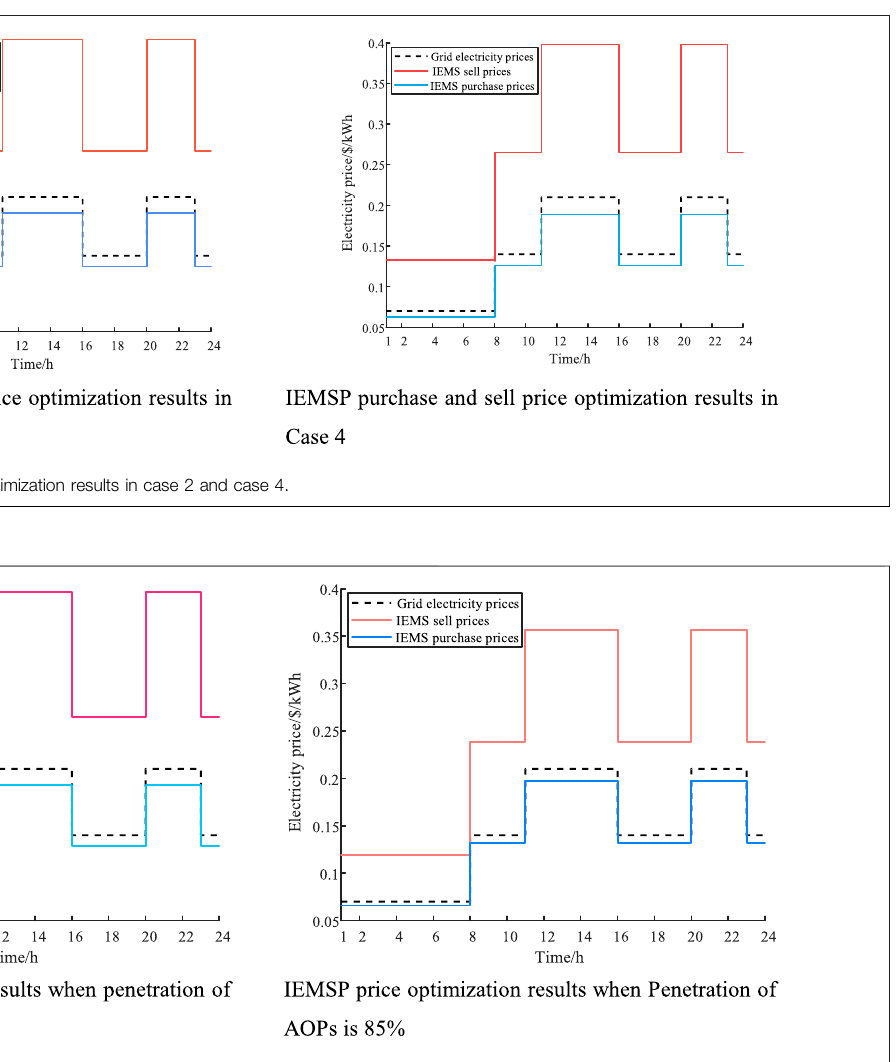
FIGURE 6 | IEMSP purchase and sell price optimization results of different penetrations of